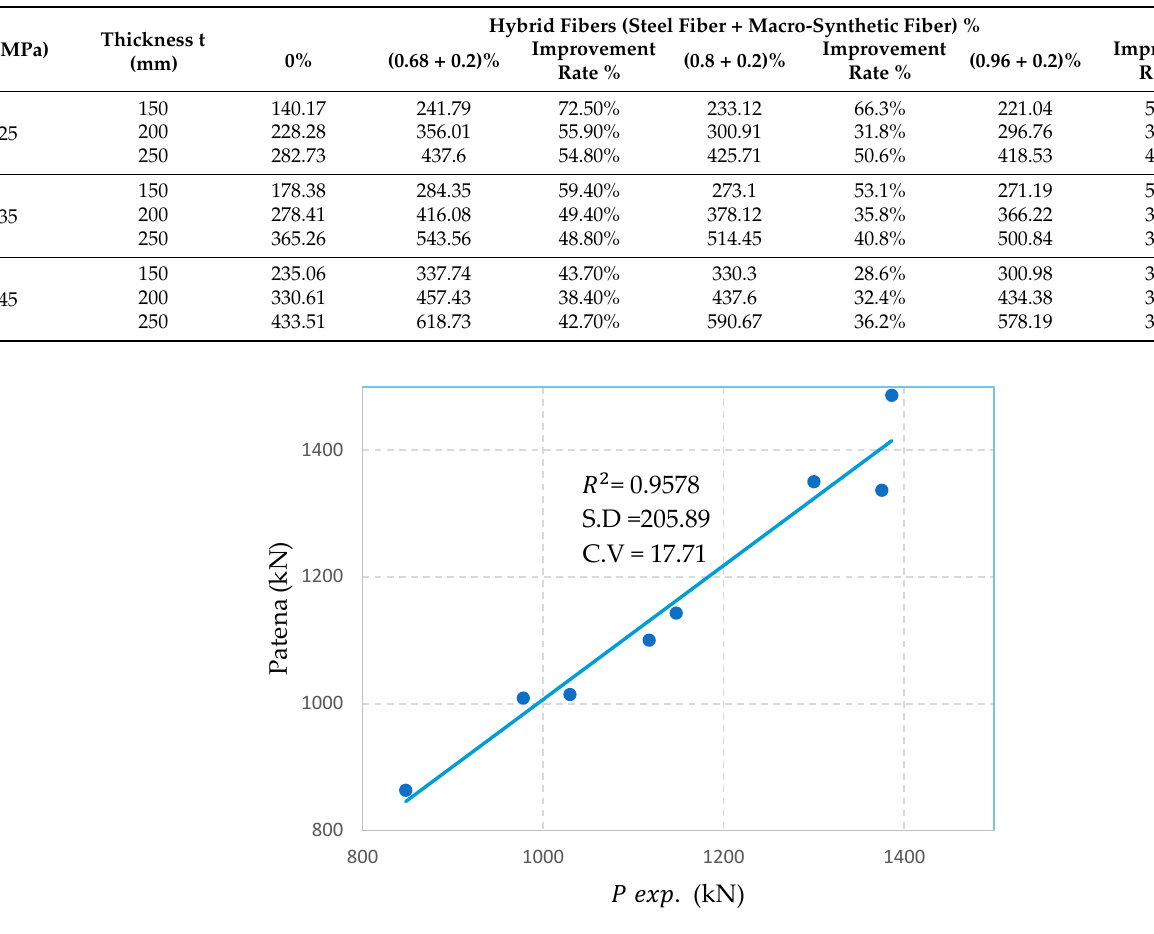
Table 4. Ultimate axle load capacity at the edge of mid slab Pu (kN) and improvement rate.